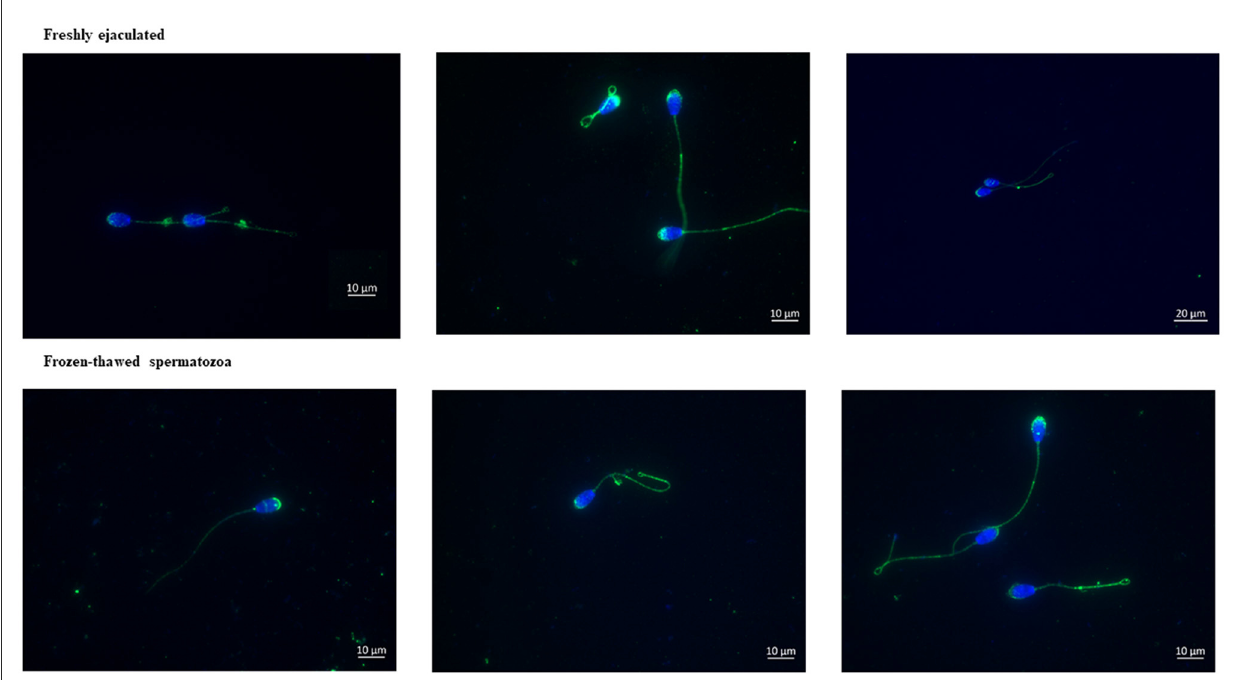
FIGURE1 Immunolabeling of AQP3 in ram (fresh and frozen-thawed spermatozoa). AQP3 is located in the acrosome, midpiece, principal piece of the tail, and end piece of the tail.